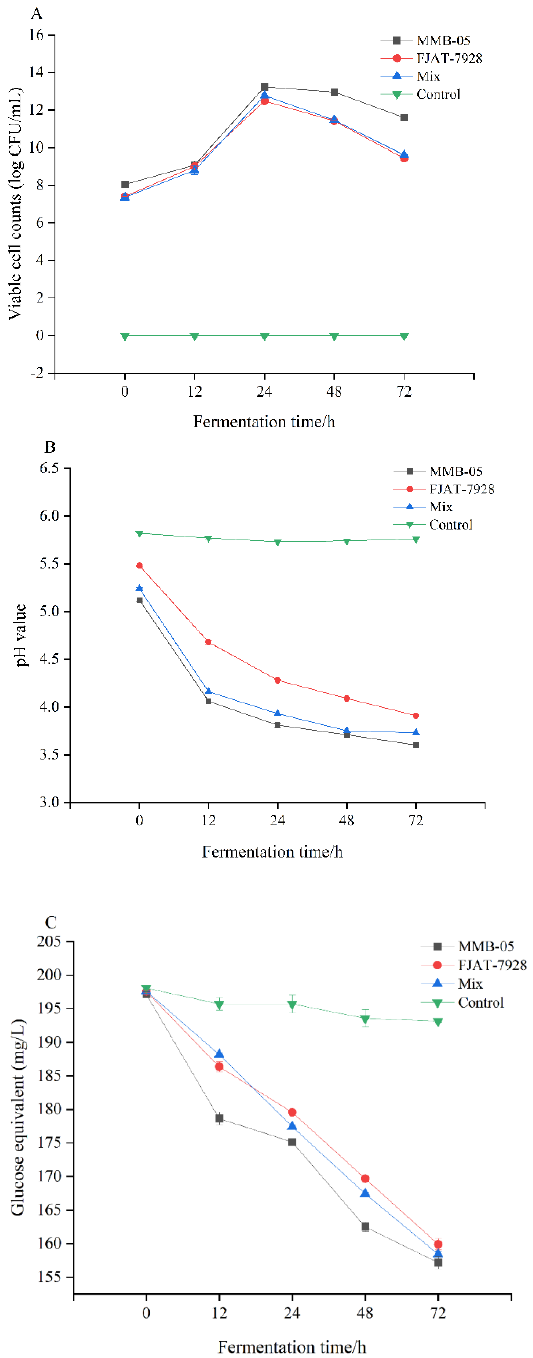
Figure 4. Changes in viable cell counts ( A ), pH value ( B ), and total sugar content ( C ), during 3 days LAB stains fermentation of P. yezoensis sauce.